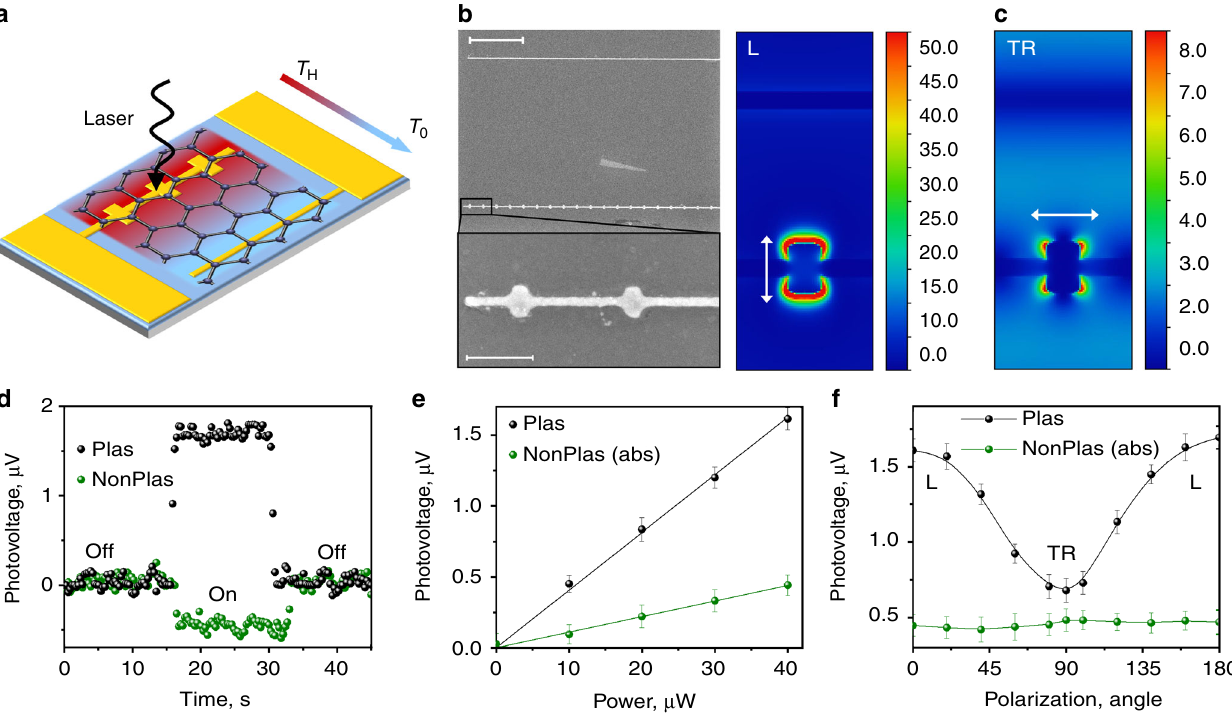
Fig. 2 Photoresponse of a metal – graphene – metal photodetector with asymmetric plasmonic contacts. a Schematic of the graphene device with plasmonic and nonplasmonic contacts. Under optical excitation of the plasmonic contact, the local electronic temperature rises to T H compared to the bath temperature ( T 0 ) resulting in the temperature gradient established across the contacts as indicated by the arrow. b Scanning electron microscopic image of the device (upper panel, scale bar is 2 µ m) and graphene/Au nanostructures (lower panel, scale bar is 300 nm). c Calculated electromagnetic fi eld distributions for longitudinal (L) and transverse (TR) polarization at 740 nm. d – f Photovoltage generated at 740 nm as a function of time ( d ), laser power ( e ) and polarization ( f ) for plasmonic (Plas) and nonplasmonic (NonPlas) contacts. For ease of comparison, the photovoltage generated for the nonplasmonic contact is presented in absolute values (abs). The measurements in d , e were performed under L polarization. The laser power in d , f is fi xed at 40 µ W. The error bars are the standard deviation in the